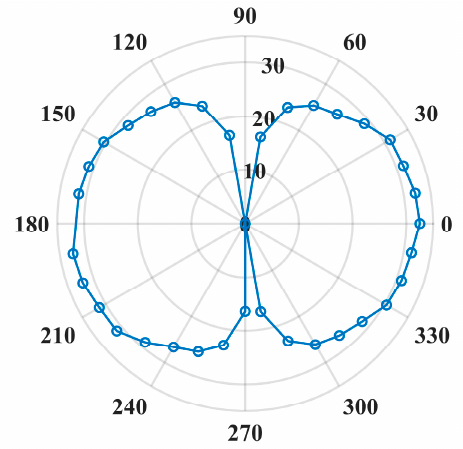
Figure 14. Directivity of the sensor measured at 32 Hz.